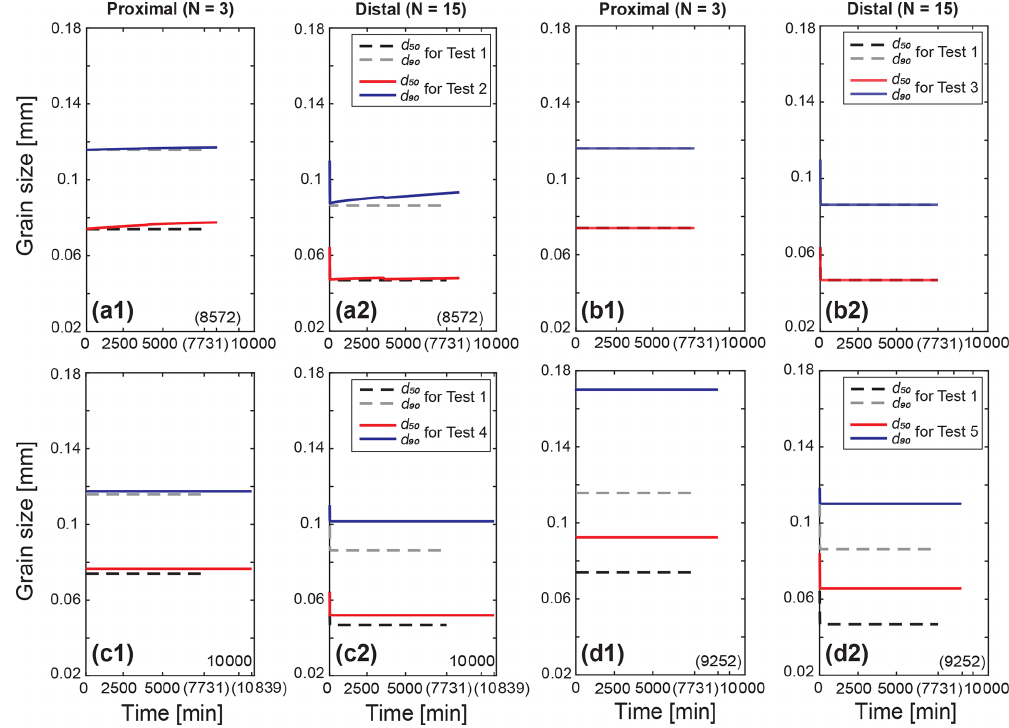
Figure 6. Time series of grain sizes d 50 and d 90 at the top levee surface at the proximal ( N = 3, x = 30m) and distal ( N = 15, x = 150m) locations marked with each simulation time, T in parenthesis. The solid lines (red and blue) indicate the grain sizes d 50 and d 90 for each test, and the dashed lines (black and gray) are for Test 1,